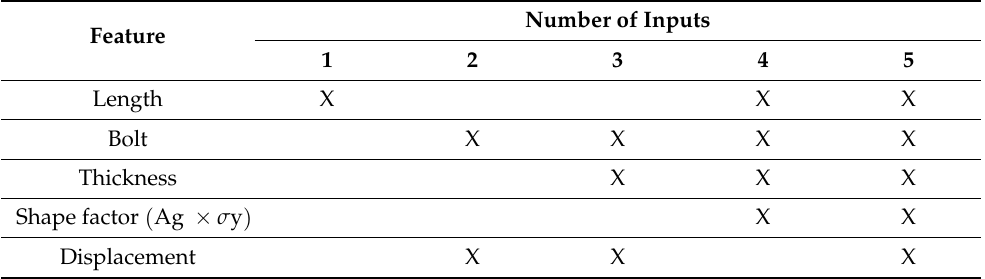
Table 11. Selected features as input for ultimate load prediction *.